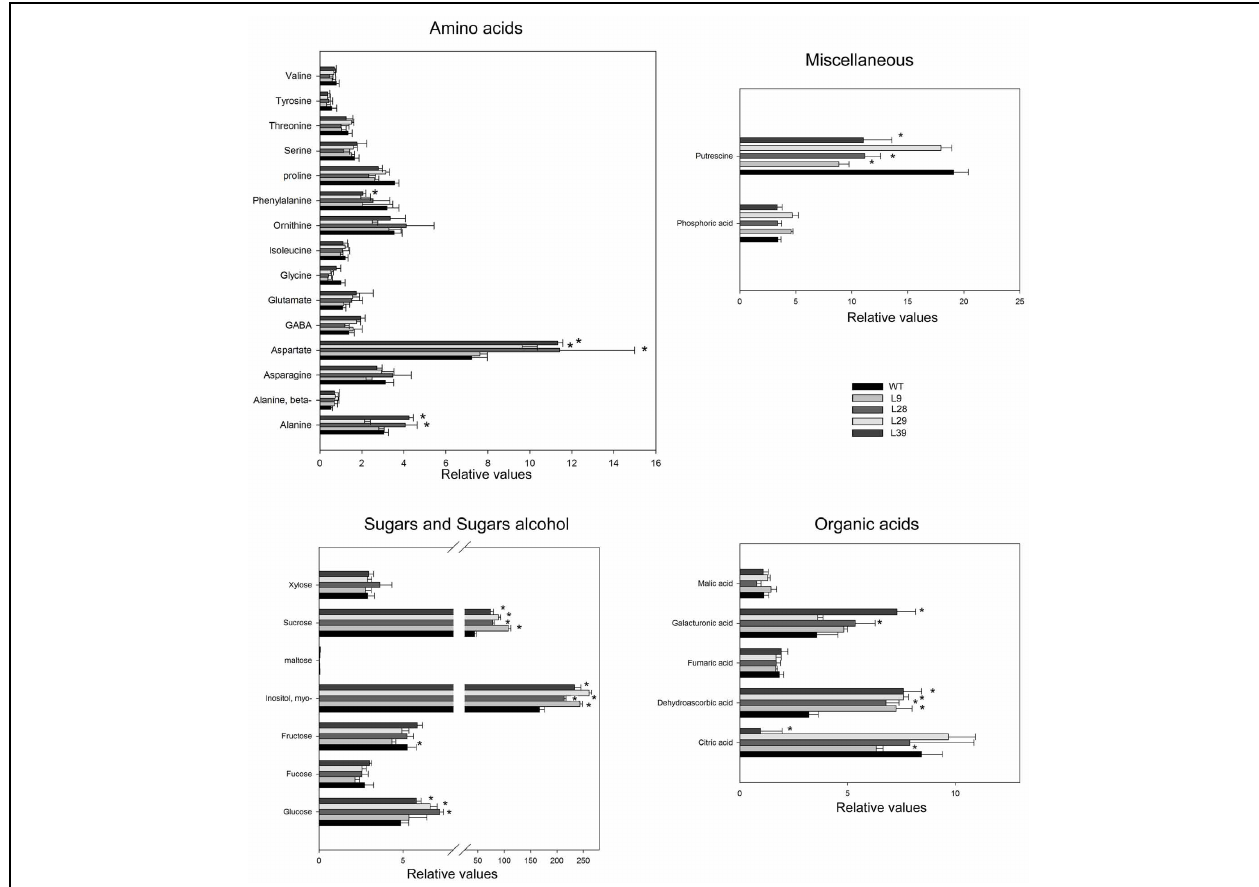
FIGURE 4 | Primary metabolite levels in the receptacle of WT and B33-PPi lines at red stage. Data are normalized to the mean value of WT at the G stage. Values are means SE of six replicates. Asterisks indicate significant differences by t- test ( P < 0 . 01) of the transgenic lines compared with WT at red stage.